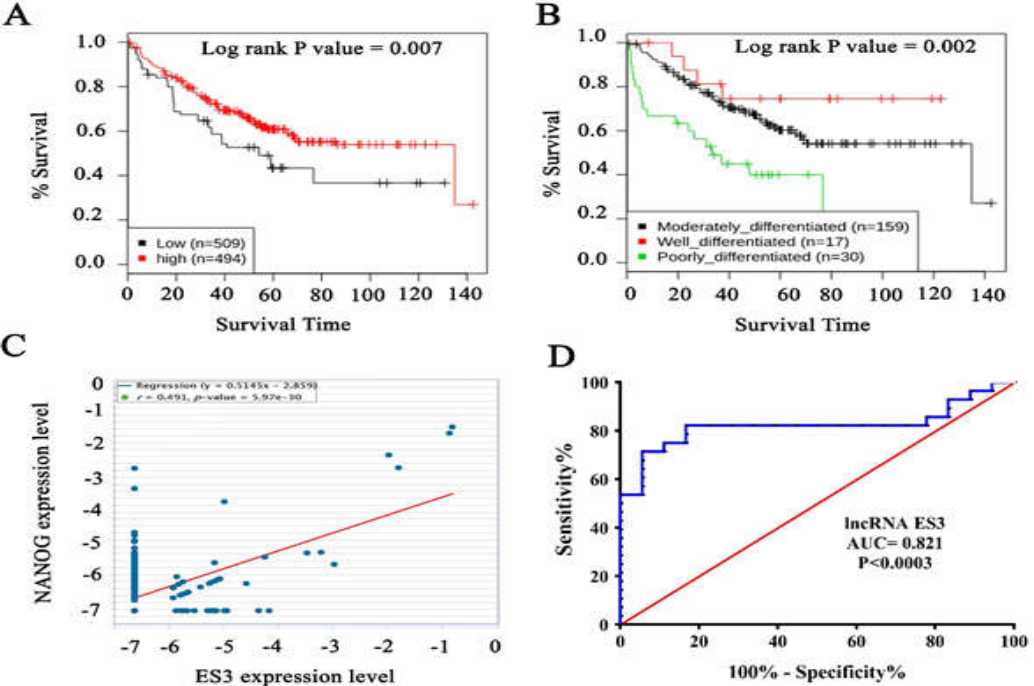
Fig. 3 . Analysis of lncRNA ES3 as a biomarker in CRC tissues based on TCGA database in ENCORI starBase v2.0 and GENT2: A) The ES3 prognostic value was detected by analyzing the clinical data from the TCGA database and the data demonstrated that it has a significant relationship with overall survival (*p = 0.007); B) The ES3 prognostic value is significantly related to survival rate in poorly differentiated of CRC (*p = 0.002); C) The significant correlation between the expression level of ES3 and NANOG in CRC was determined by employing the clinical data from TCGA which was obtained from ENCORI: The Encyclopedia of RNA Interactomes. (*p = 0.005); D) According to the receiver operating characteristic (ROC) curve, the part below the (AUC)–ROC curve introduces lncRNA ES3 as new a diagnostic biomarker in patients with CRC (*p =